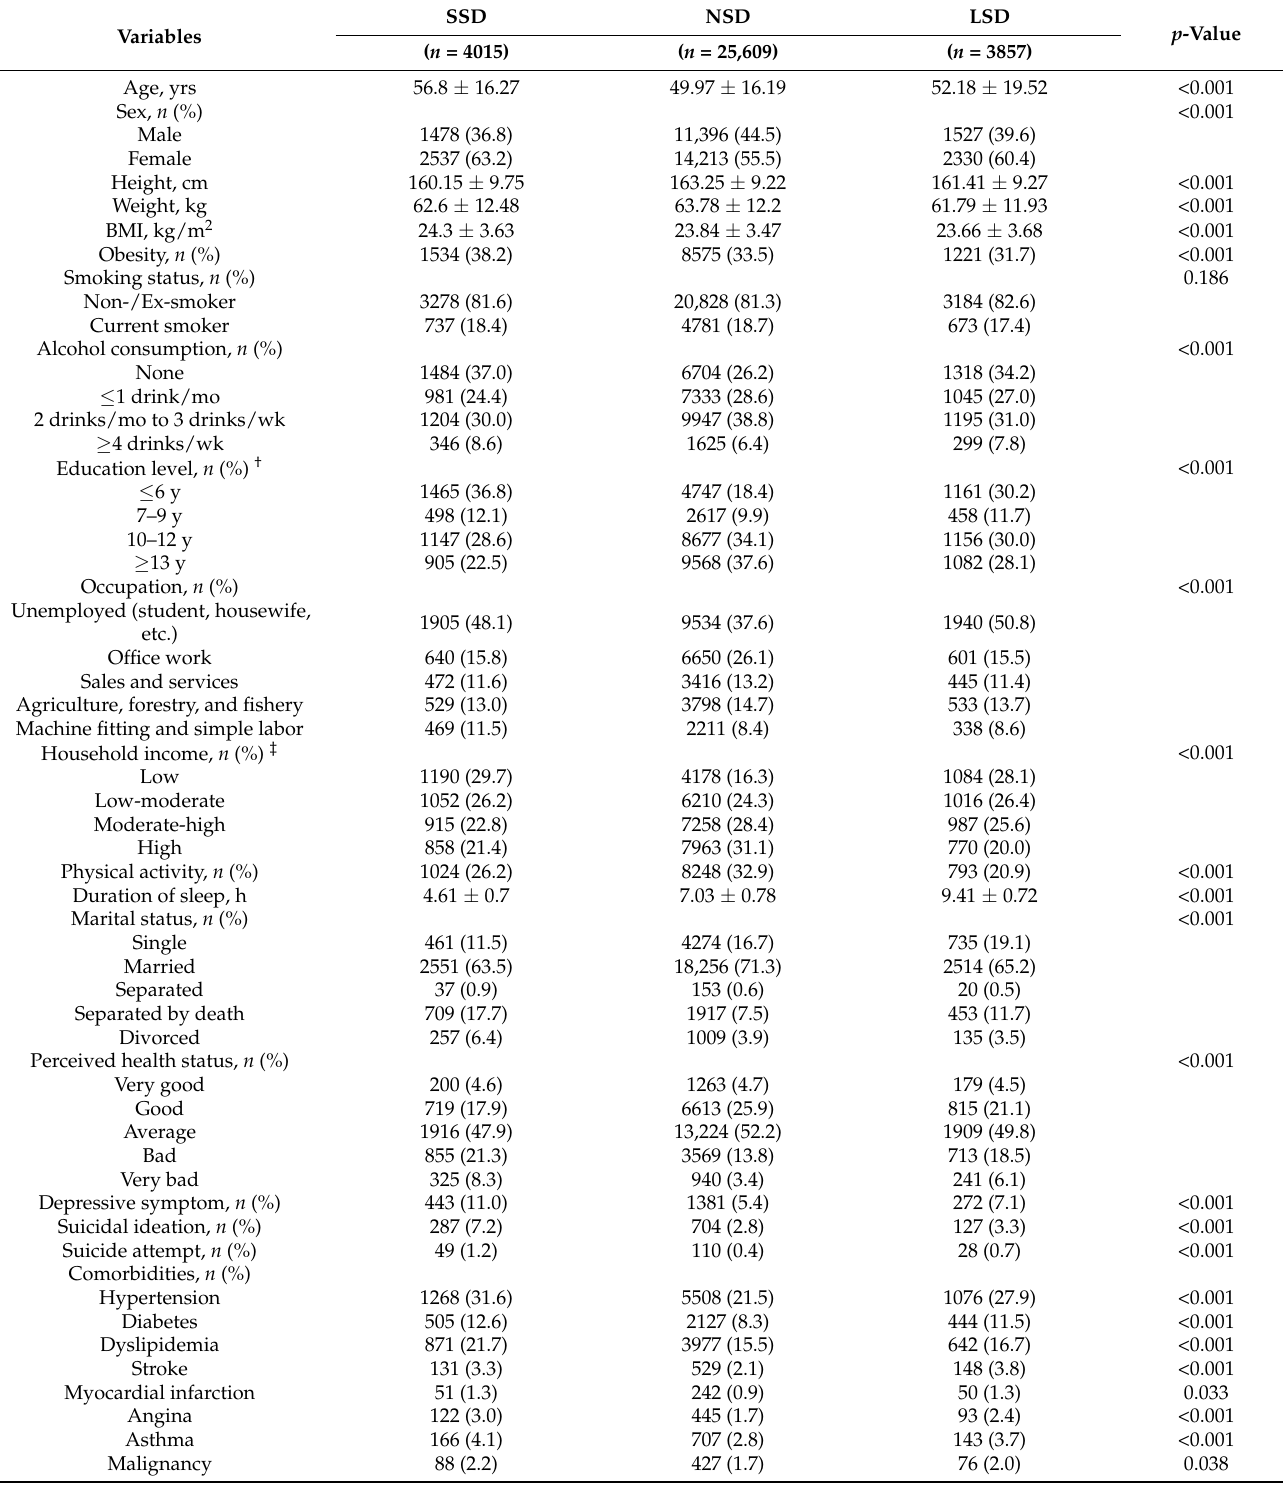
Table 1. Baseline characteristics according to sleep duration for the study